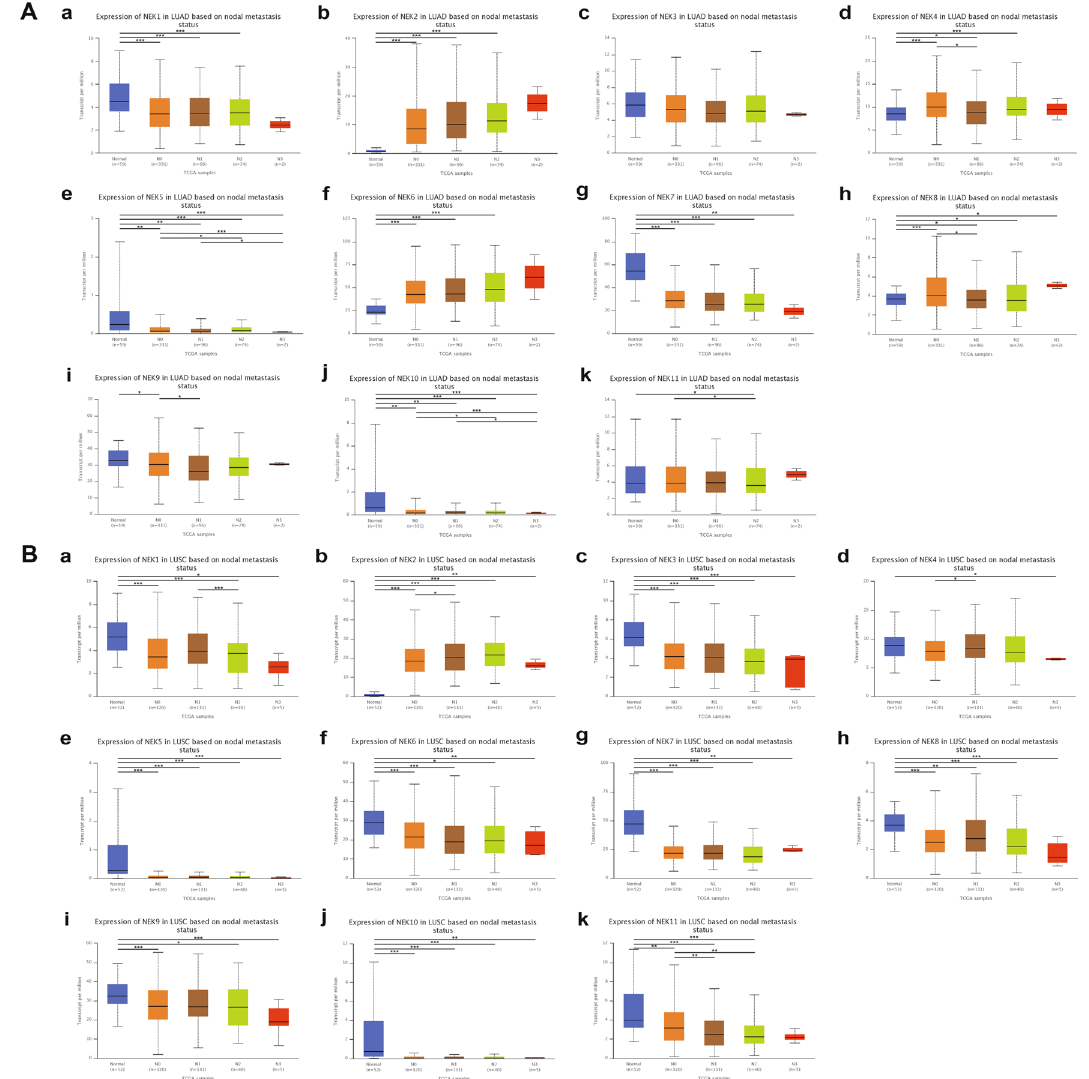
Figure 5. Relationship between mRNA expression of distinct NEKs family members and individual nodal metastasis status of NSCLC patients. A From a to k represent the relationship between mRNA expression of NEK1 to NEK11 and individual nodal metastasis status of LUAD patients; B From a to k represent the relationship between mRNA expression of NEK1 to NEK11 and individual nodal metastasis status of LUSC